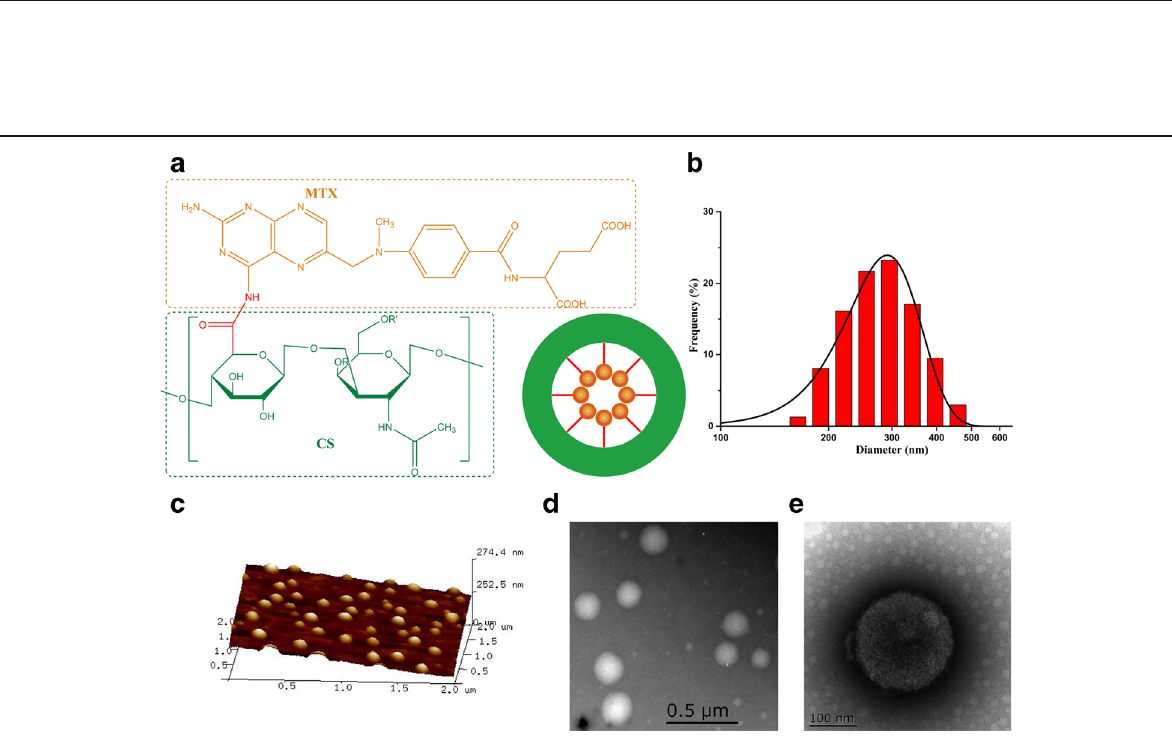
Fig. 3 Schematic illustration of the MTX-CS NGs. Dynamic light scattering (DLS), atomic force microscope (AFM), and transmission electron microscopy (TEM) characterization of MTX-CS NGs. a Schematic illustration of the MTX-CS NGs. b Size of MTX-CS NGs measured by DLS in representative experiments. c AFM images of MTX-CS NGs. d , e TEM images of MTX-CS